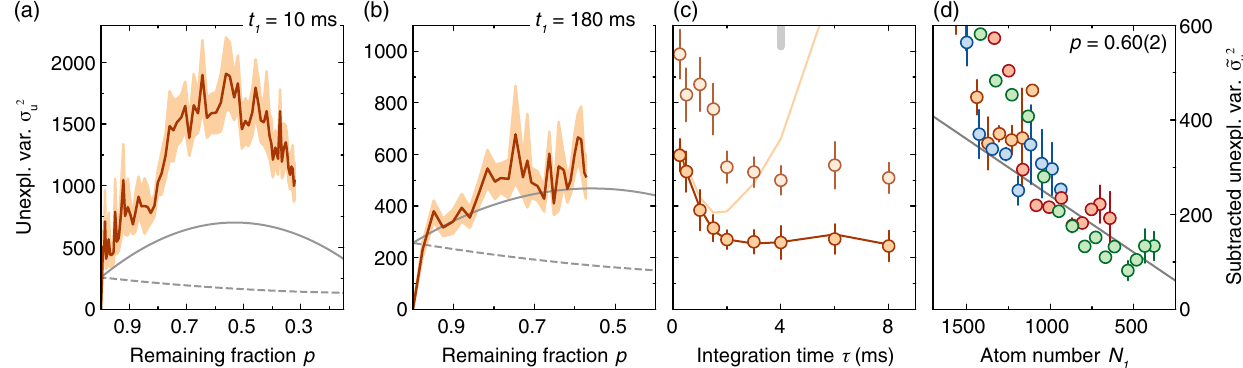
FIG. 4. Mesoscopic fluctuations of the evaporation process. (a) Unexplained variance σ 2 intracavity photon number n ¼ 1 . 9 ð 1 Þ at initial time t 1 ¼ 10 ms and (b) at t 1 ¼ 180 ms, with the standard deviation calculated by bootstrapping indicated by the shaded region. The solid gray lines show the model prediction including Poissonian stochastic noise and measurement noise; the dashed lines show the prediction without the contribution of Poissonian stochastic noise. (c) Unexplained variance σ 2 for p ≈ 1 ( t 2 ¼ t 1 þ τ , darker points) and p ¼ 0 . 60 ð 2 Þ [ t 2 ¼ t 1 þ 95 ð 5 Þ ms, lighter points] for different integration times τ . u For p ≈ 1 , the unexplained variance corresponds to twice the reduced Allan variance (solid orange line). The bright orange line denotes the full Allan variance without subtracting the mean dynamics [see Fig. 1(e)]. The gray tick indicates the integration time τ ¼ 4 ms that minimizes σ 2 and is used to produce the curves shown in (a) and (b). (d) Scaling of unexplained variance for fixed lost fraction u p ¼ 0 . 60 ð 2 Þ with initial atom number N 1 . The constant measurement noise is subtracted from the data for each n , to compare different n (color coded as in Fig. 2). The gray solid line denotes the linear Poissonian expectation ˜ σ 2 one standard